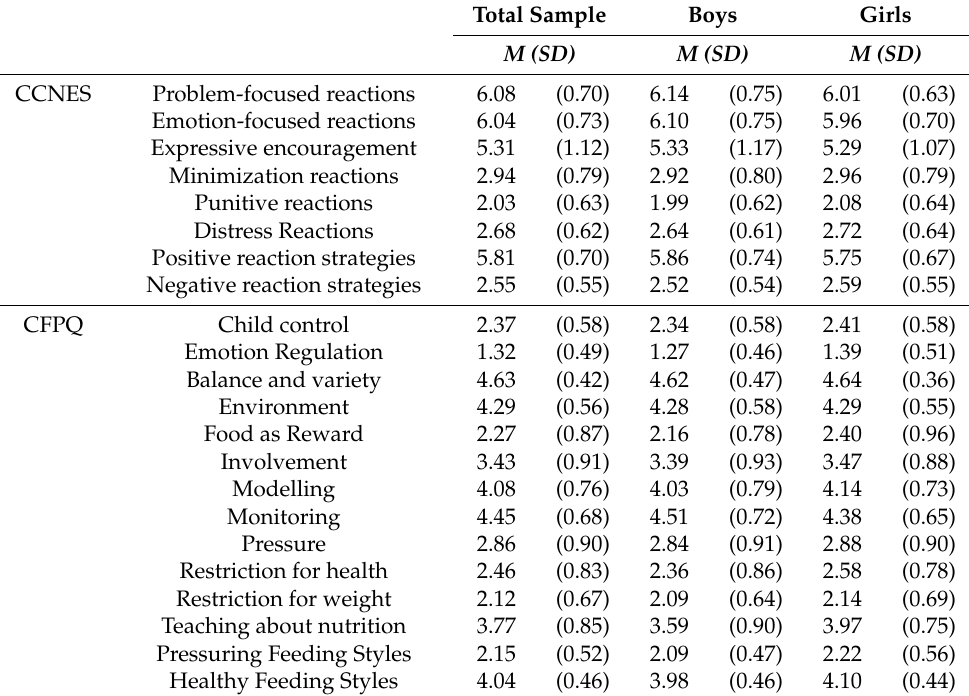
Table 1. Descriptive Statistics for the Coping with Children’s Negative Emotions Scale and Compre- hensive Feeding Practices